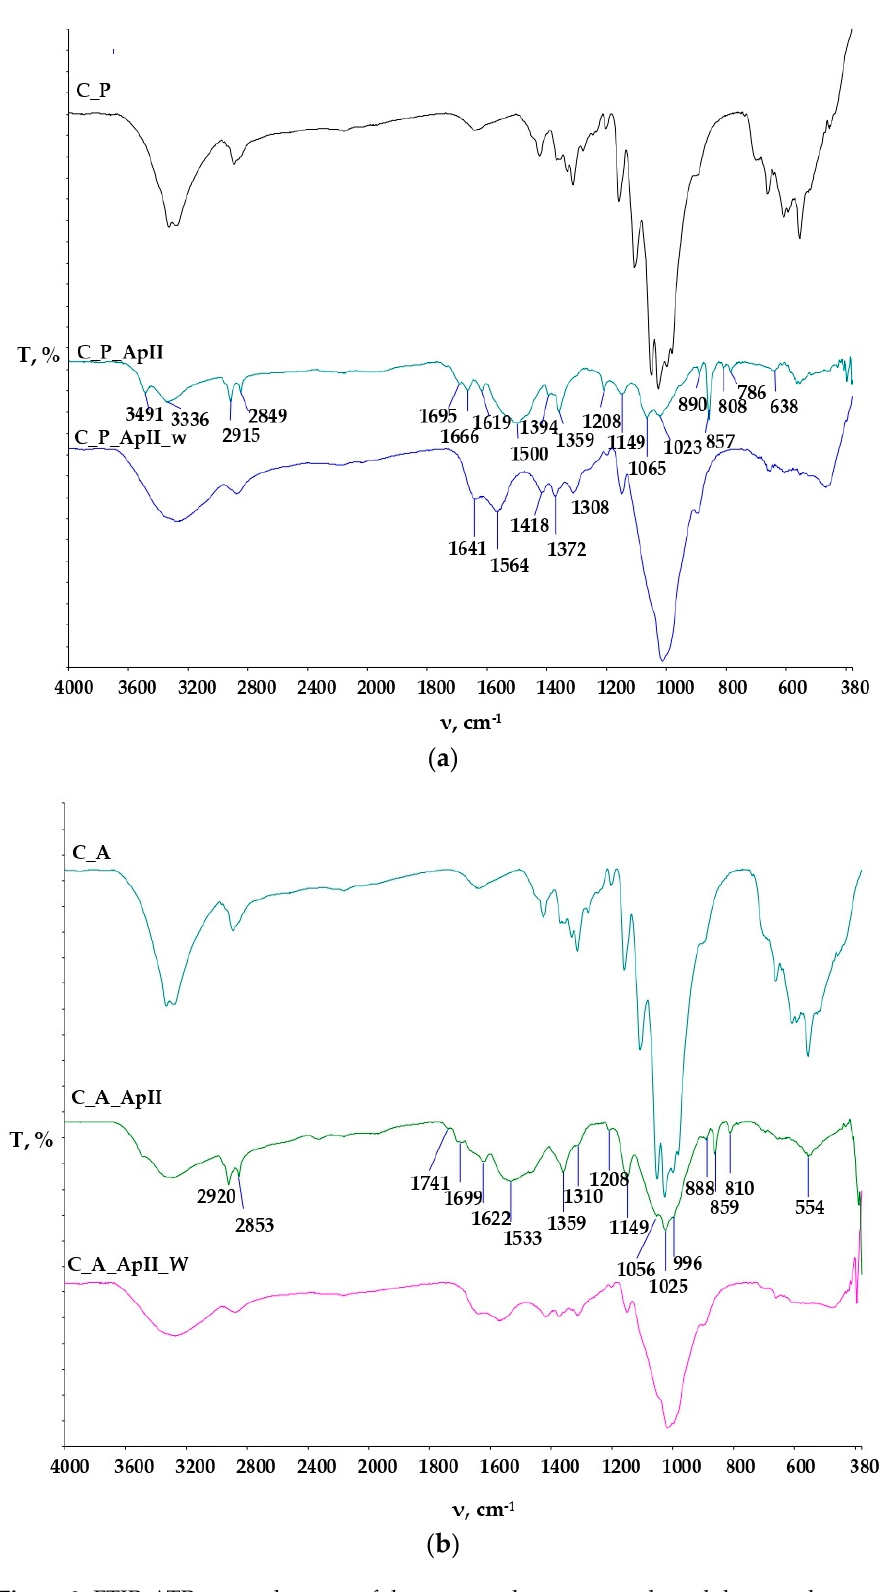
Figure 9. FTIR-ATR spectral curves of the untreated cotton sample and the sample treated in ApII before and after the care cycle (ApII_w): ( a ) In the plain weave (C_P), ( b ) in the satin weave (C_A).